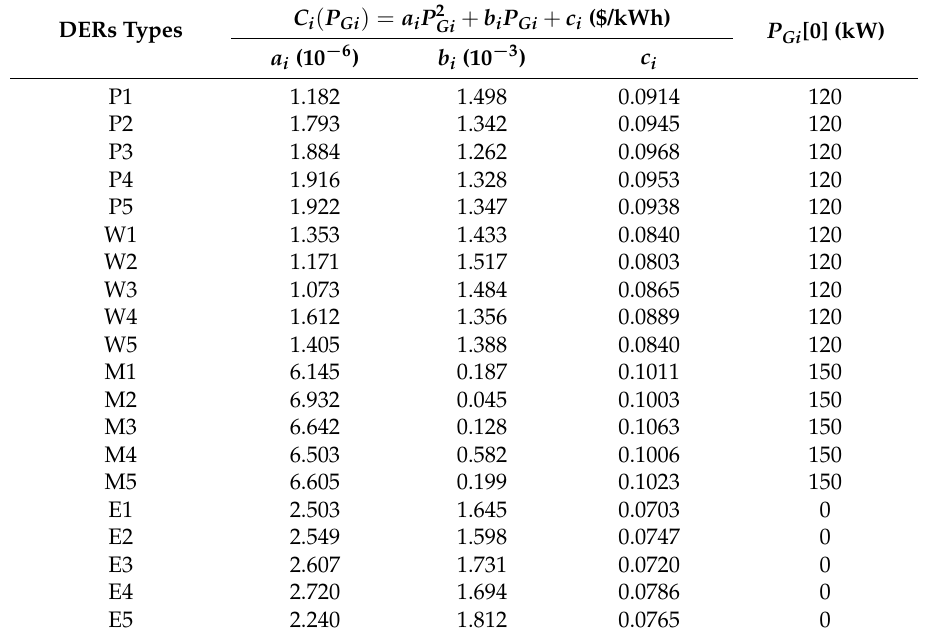
Table 1. Parameters of DERs.